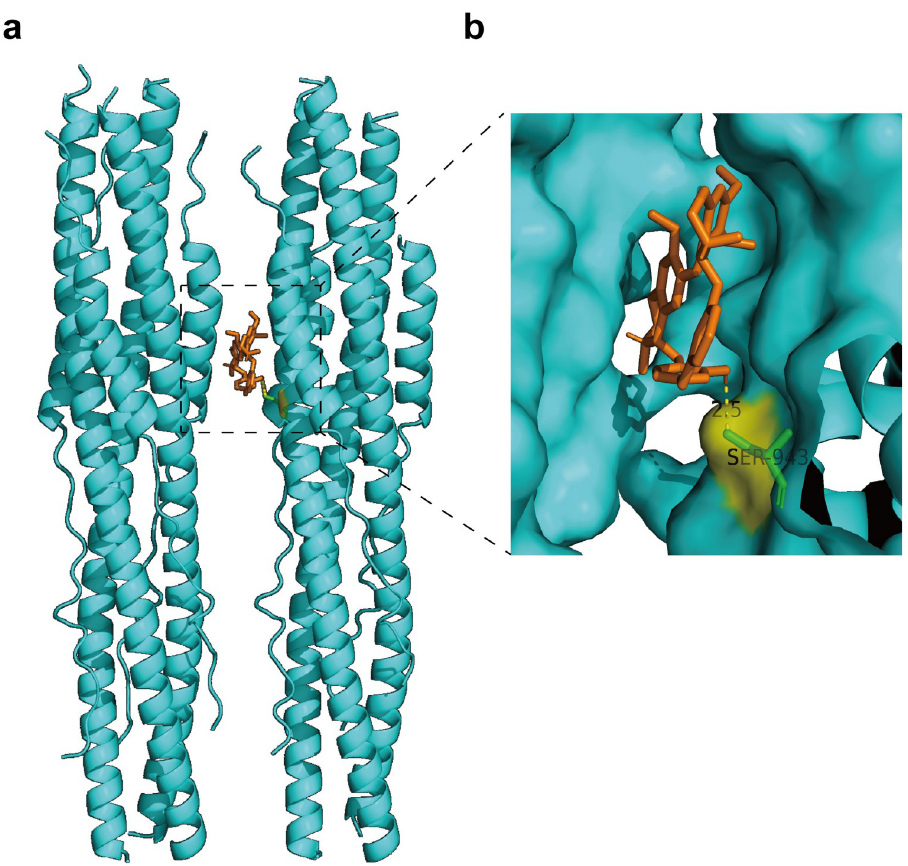
Fig 5. Generated the binding mode of berbamine hydrochloride in the post fusion core of SARS-CoV-2 S2 subunit. The 3D structure of berbamine hydrochloride and proteins were obtained from ZINC (ID: ZINC38139356) and PDB (ID: 6LXT) databases, respectively. The interaction sites between berbamine hydrochloride and S2 were predicted by Autodock vina algorithm. The SARS-CoV-2 S2 residues involved in berbamine hydrochloride binding are shown as green